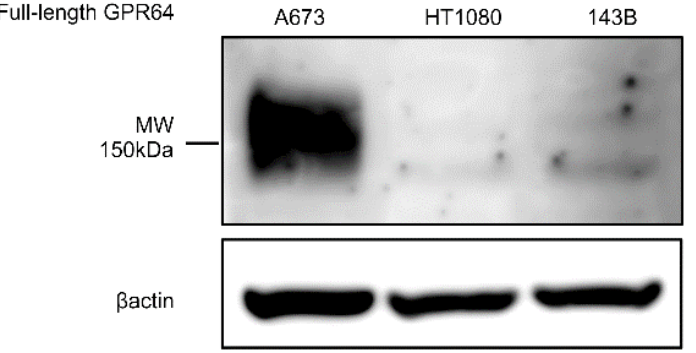
Figure 5. Immunoblotting of tumor lysates extracted from A673, HT1080, and 143B cells. Antibodies against GPR64 and β -actin were used. A specific band was detected for GPR64 at approximately 150 kDa.